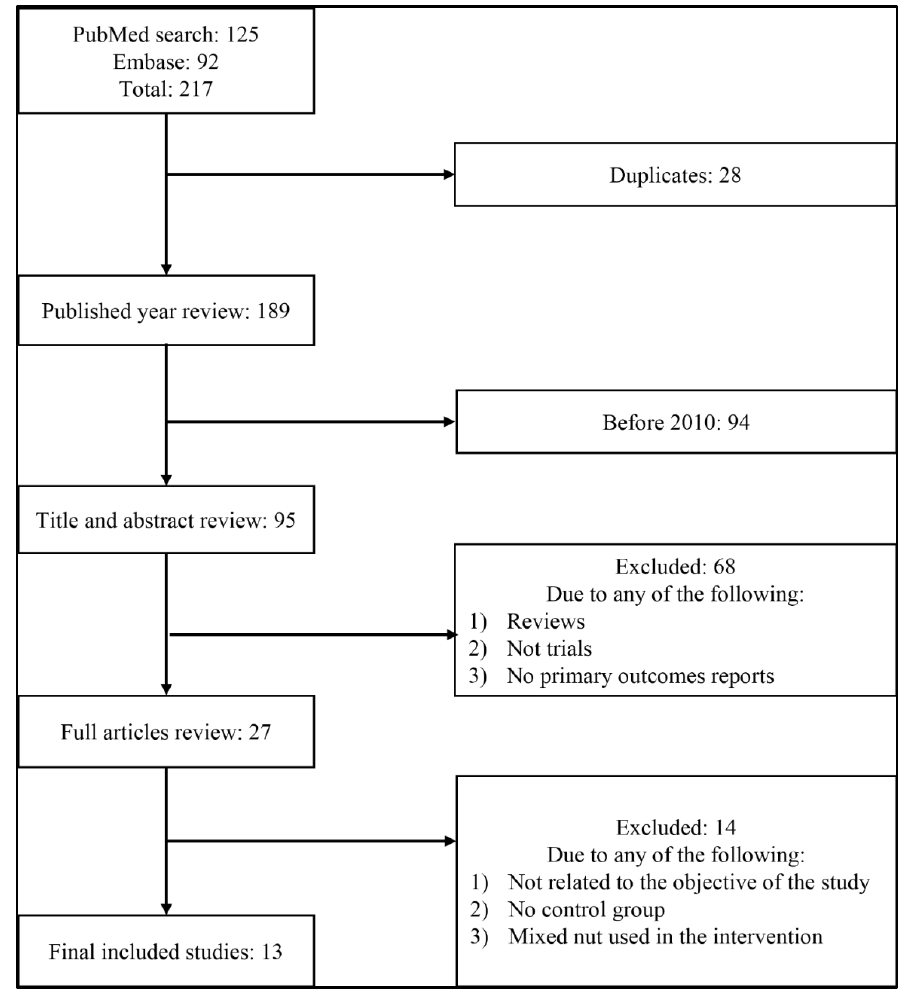
Figure 1. PRISMA flowchart of study selection process for the meta-analysis.